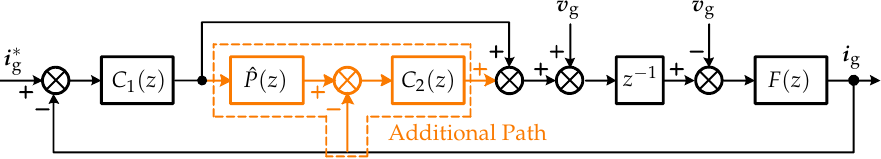
Figure 3. The proposed closed-loop control against voltages measurement